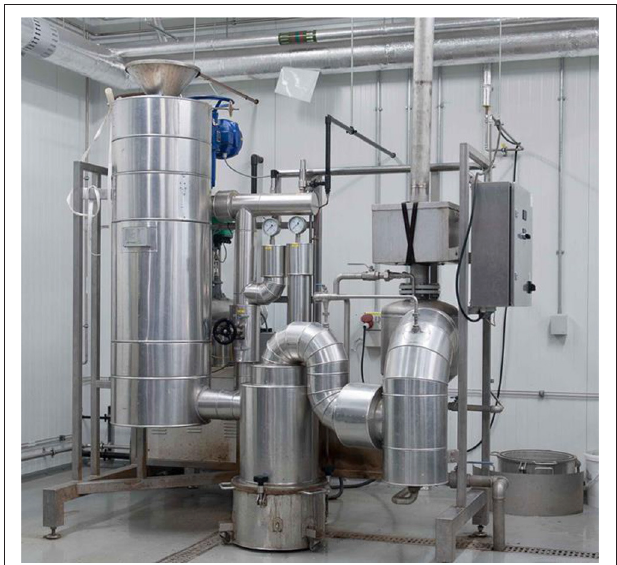
FIGURE 1 | BEACON Biorefining Centre of Excellence 30L Cambi SE